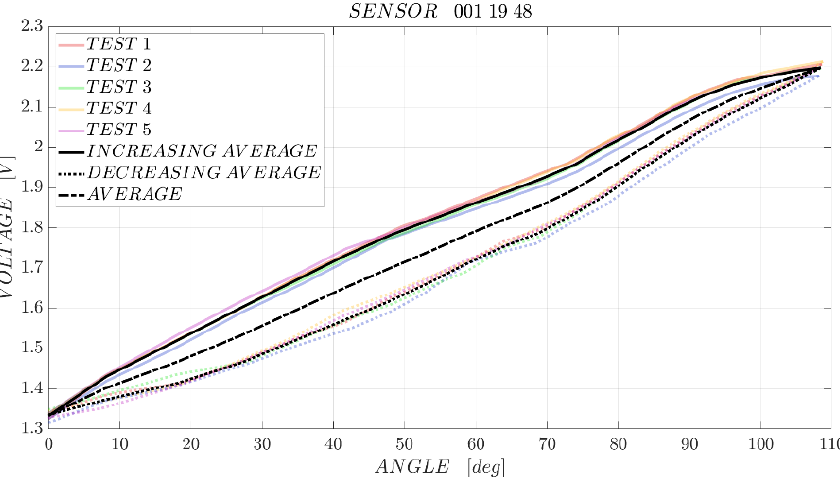
Figure 26. Sensor 001 19 48: interpolation curve.